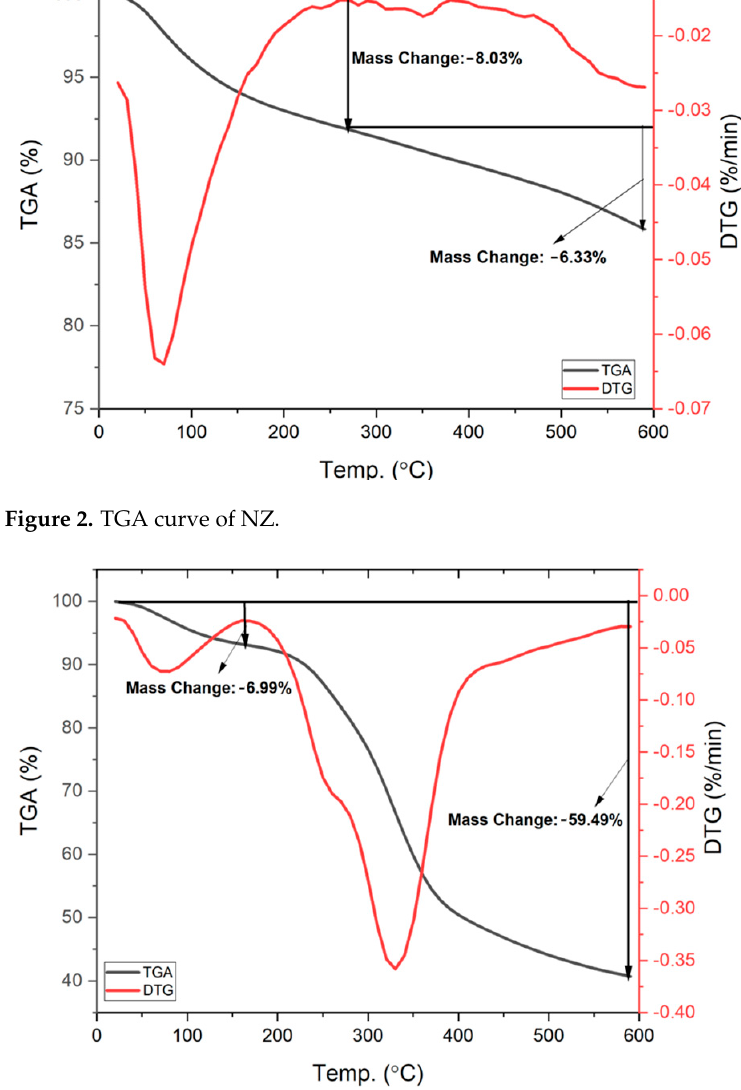
Figure 3. TGA curve of the PCD-zeolite.